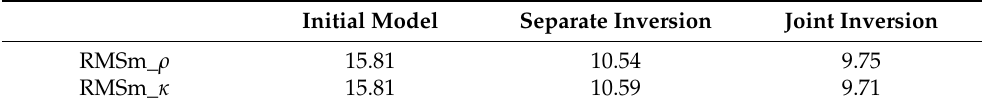
Figure 18. Slice of density (up) and magnetization (down) at y = 5000 m. ( a , d ) Real model; ( b , e ) separate result; ( c , f ) joint result. Table 8. RMSm of inversion results.